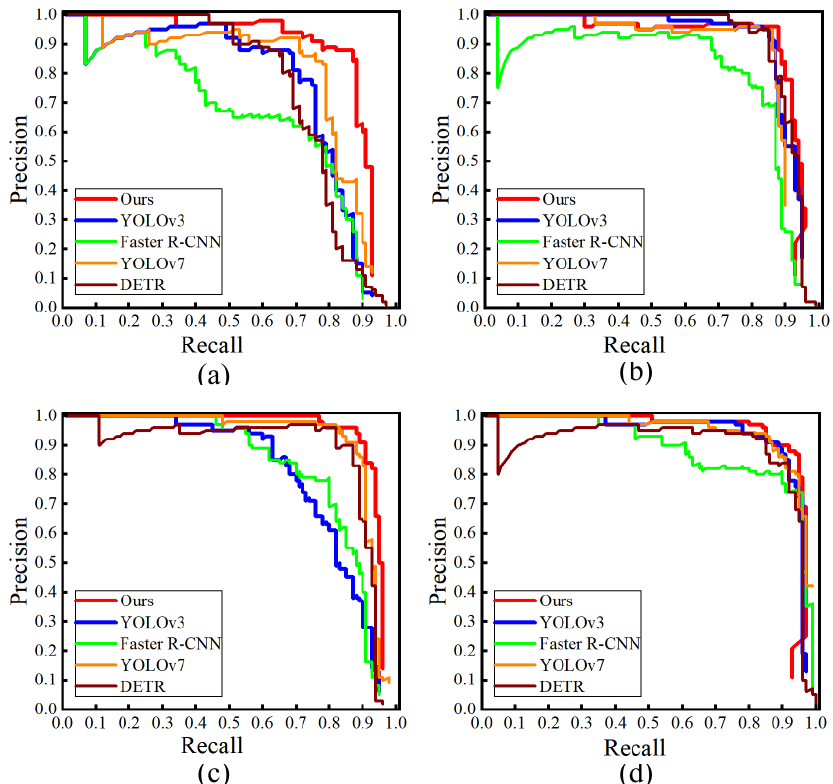
Figure 12. Precision–recall curves for different models: ( a ) P–R curve for crack; ( b ) P–R curve for deposition; ( c ) P–R curve for root; and ( d ) P–R curve for stagger.